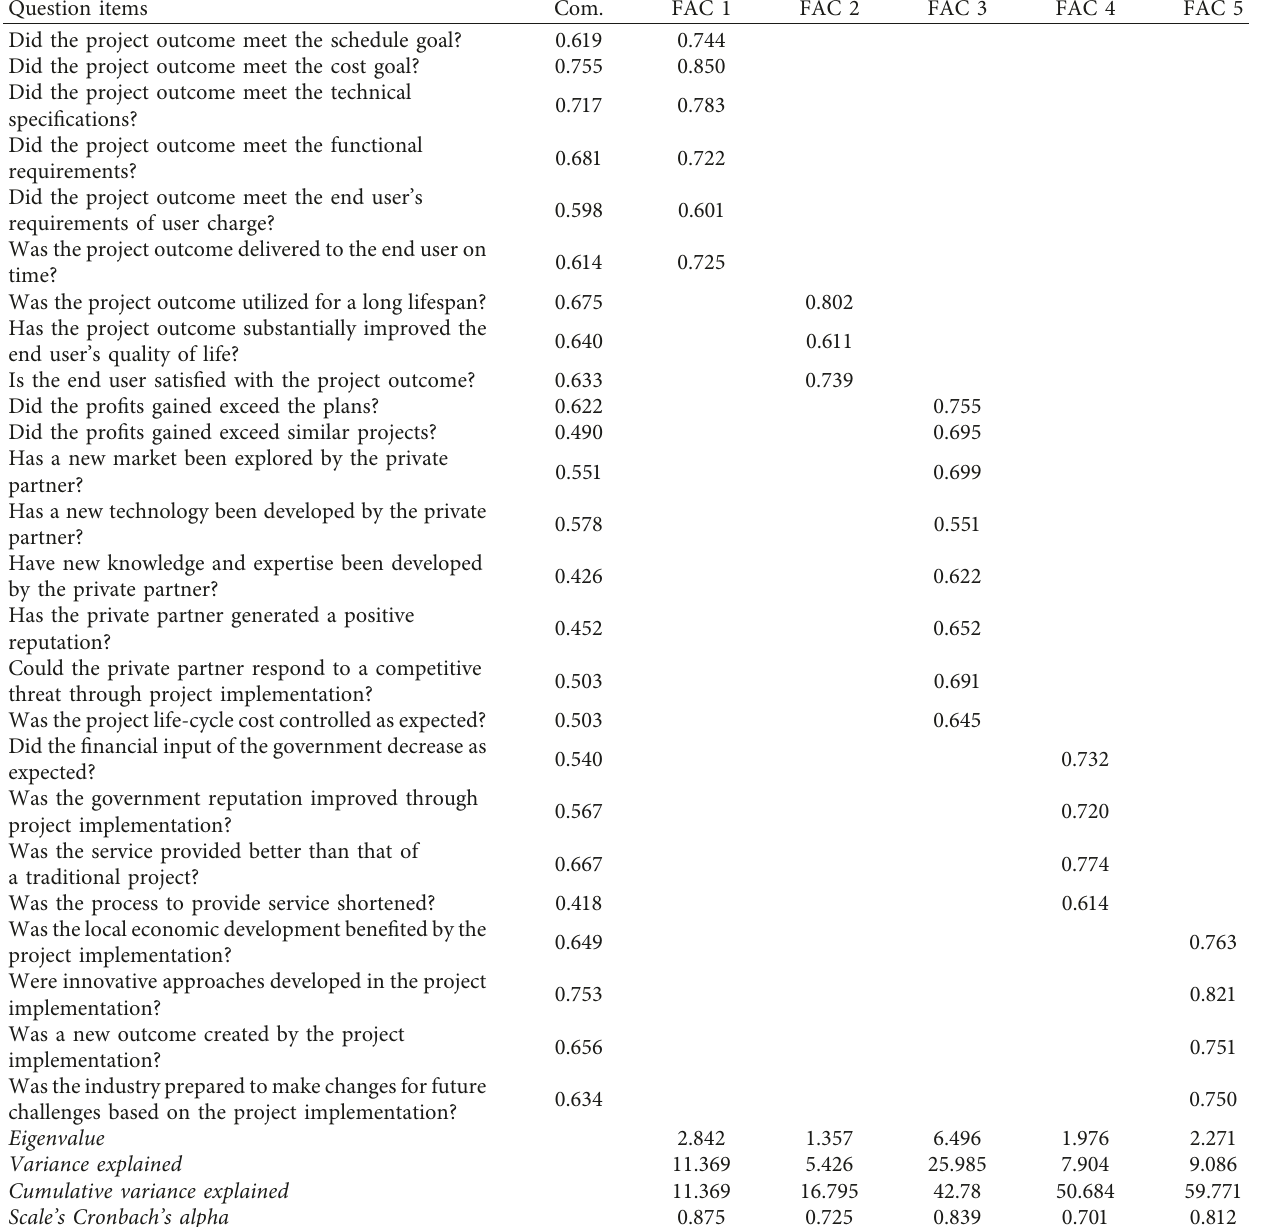
Table 8: Exploratory factor analysis of Public-Private Partnership project success